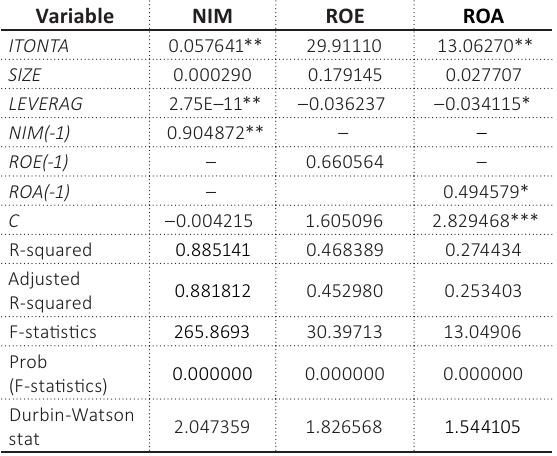
Table 6. Effect of IT investment on measures of bank profitability